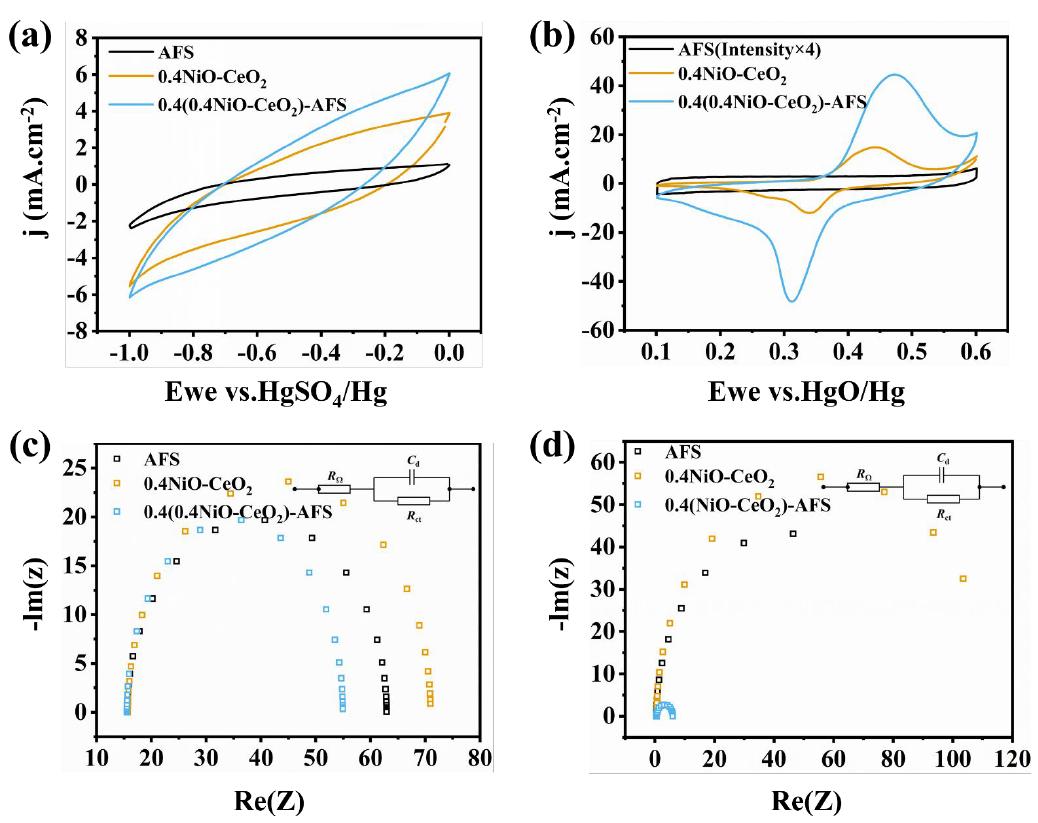
Figure 6. CV curves in acid ( a ) and alkali ( b ) and EIS Nyquist curves in acid ( c ) and alkali ( d ) for AFS, 0.4NiO − CeO 2 , and 0.4(0.4NiO − CeO 2 ) − AFS.